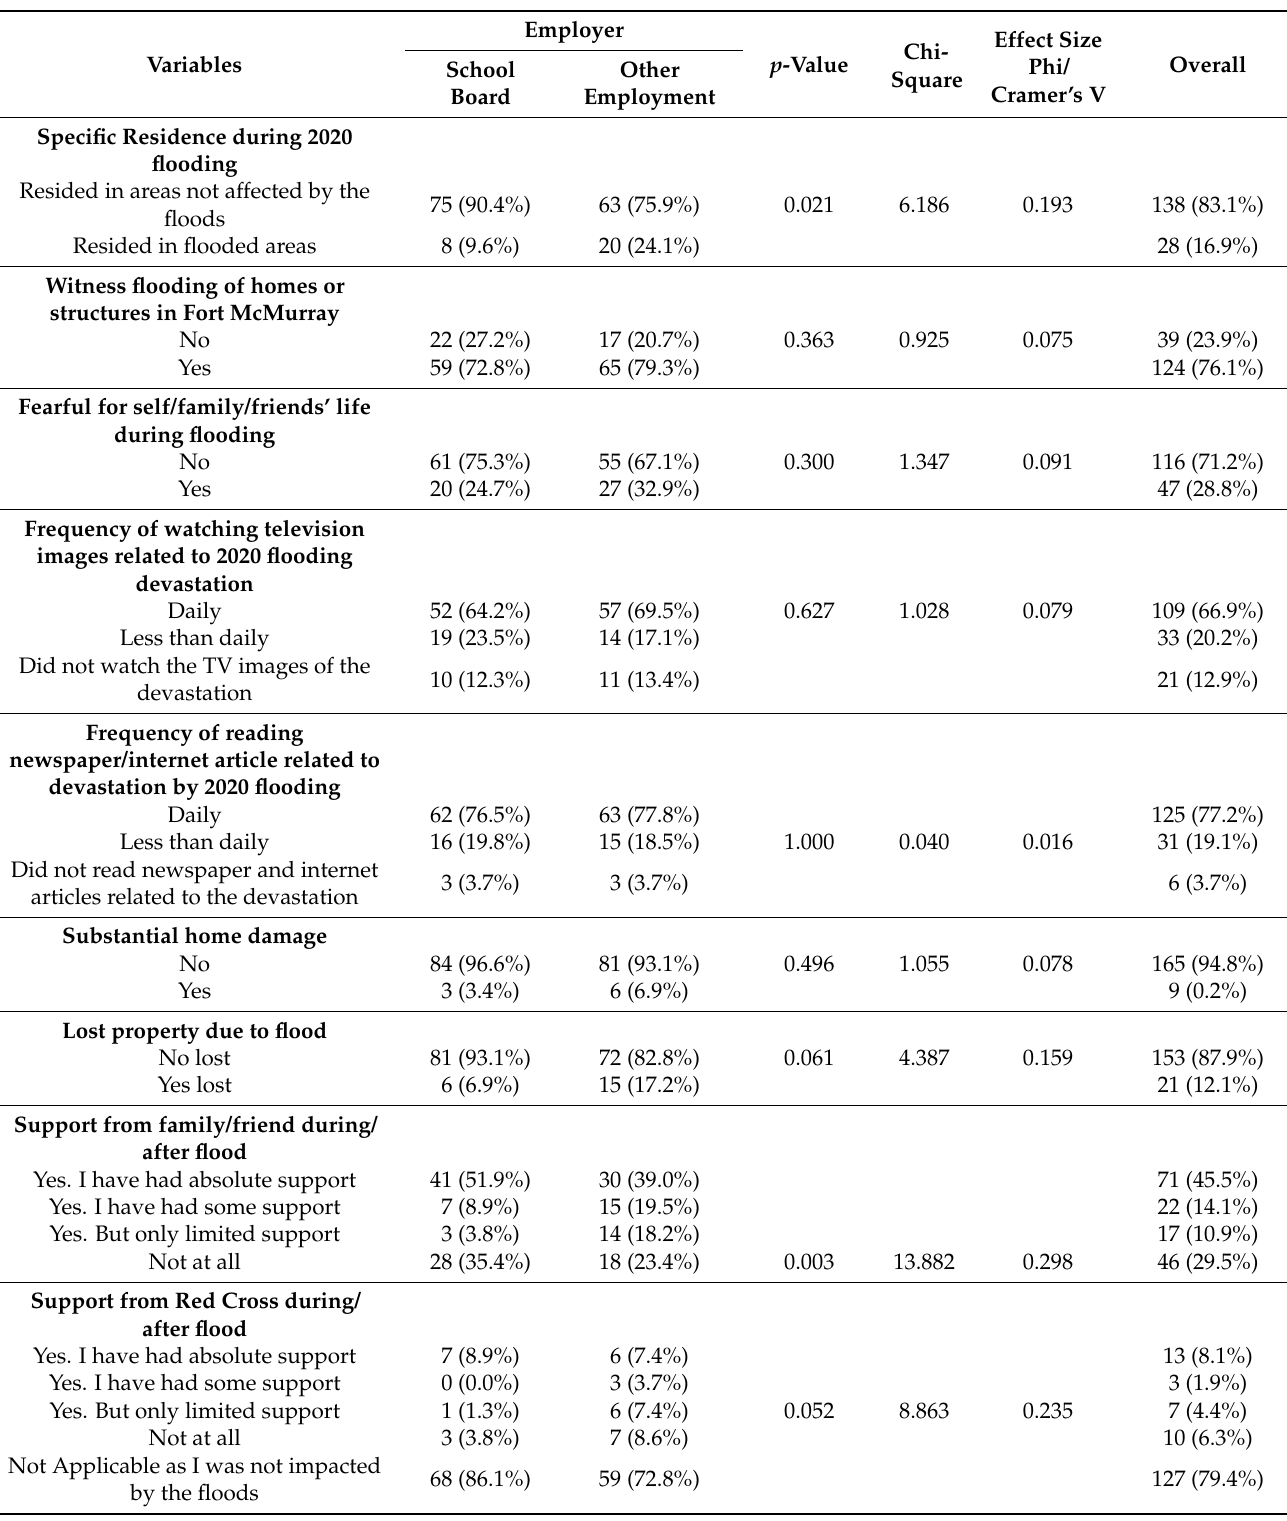
Table 2. Chi-square test of association between employer type and flooding related